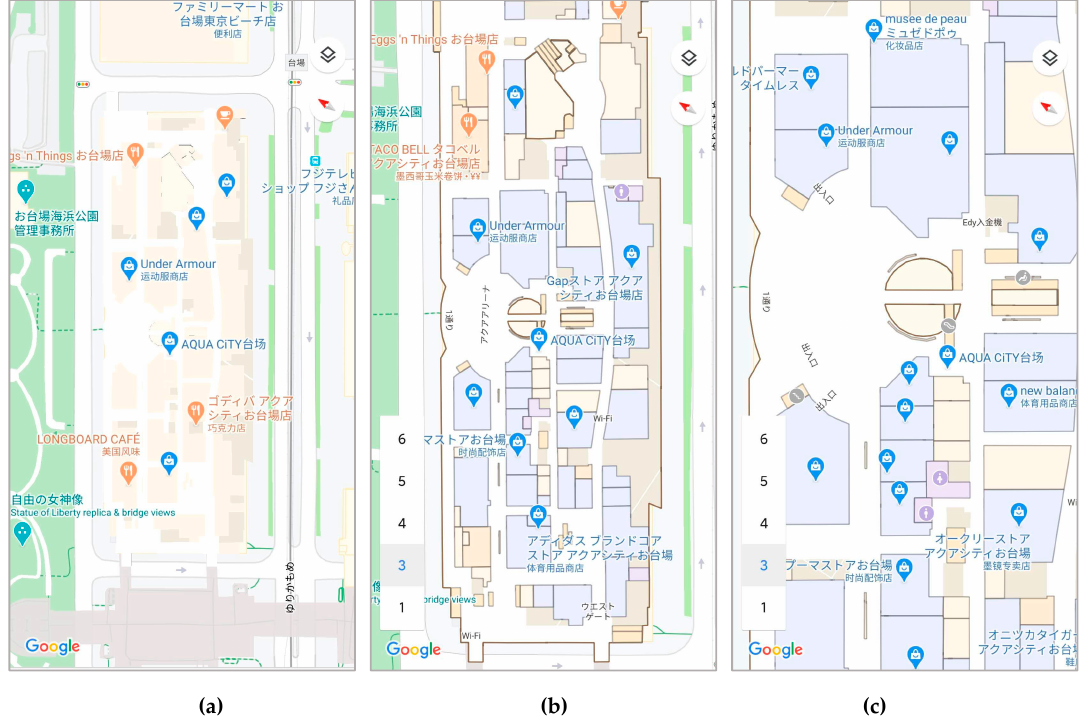
Figure 11. Examples of Google Indoor Maps at di ff erent scales, used with permission from Google: ( a ) smaller scale;( b ) medium scale; ( c ) larger